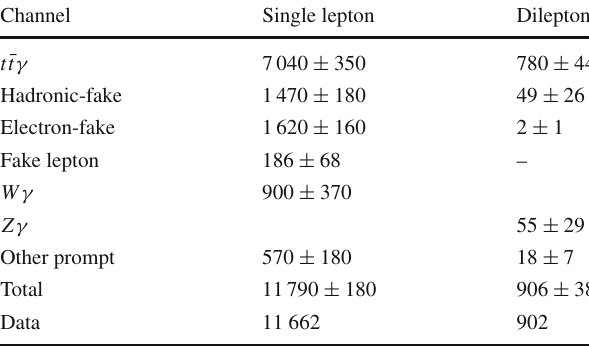
Table 4 The observed data and post-fit event yields for the signal and backgrounds in the single-lepton and dilepton channels. All data-driven corrections and systematic uncertainties are included. The fake-lepton background in the dilepton channel is negligible, represented by a “-”. The Z γ ( W γ ) background in the single-lepton (dilepton) channel is included in “Other